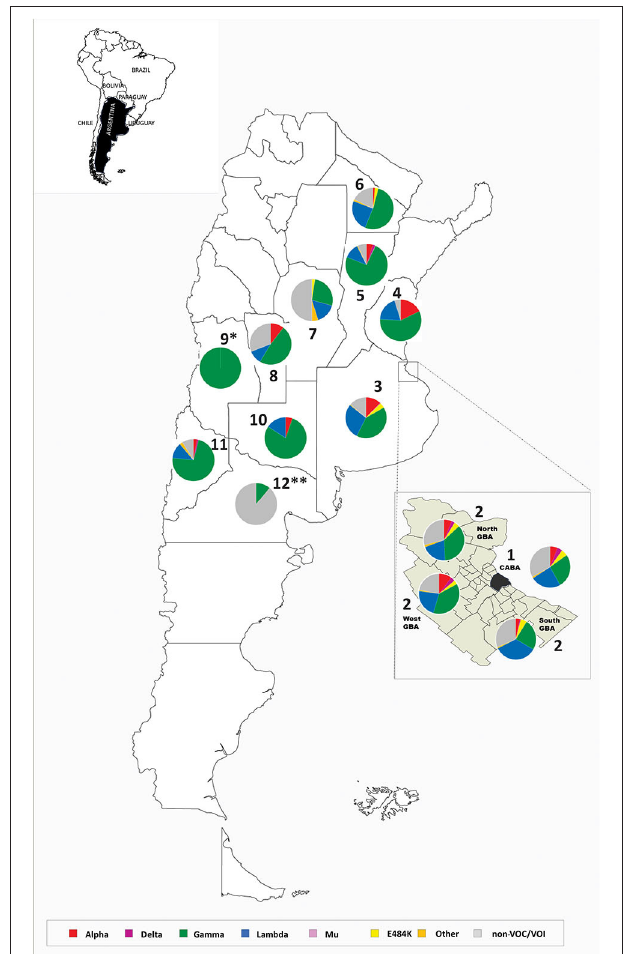
FIGURE 1 | Location of cases analyzed in this work and pie charts representing the frequency of each variant detected in every region between EW44/2020 and EW41/2021. 1. Buenos Aires city, 2. Great Buenos Aires (North, West, South), 3. Province of Buenos Aires, 4. Province of Entre Ríos, 5. Province of Santa Fe, 6. Province of Chaco, 7. Province of Córdoba, 8. Province of San Luis, 9. Province of Mendoza, 10. Province of La Pampa, 11. Province of Neuquén, and 12. Province of Río Negro. *cases associated with an outbreak ( n = 15) ( Supplementary Table 1 ). **cases ( n = 9) mainly associated with the first part of the period analyzed ( Supplementary Table 1